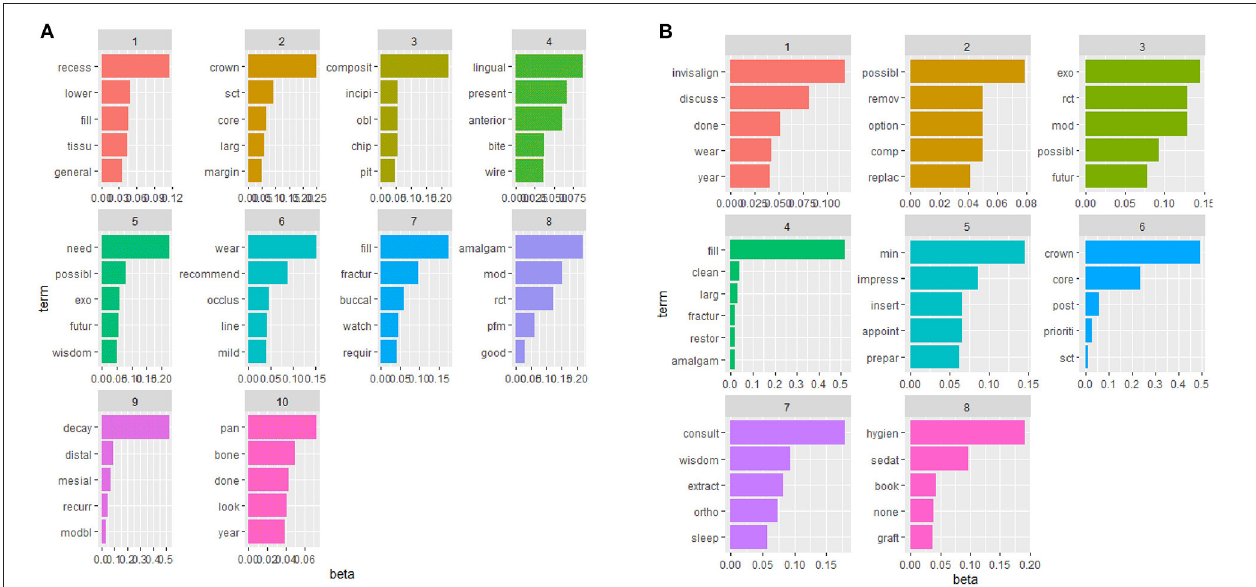
FIGURE 3 | Extracted topics for radiographic findings and treatment plan using TM [x-axis denotes for beta (per-topic word distribution) and y-axis represents the five most frequent terms across each